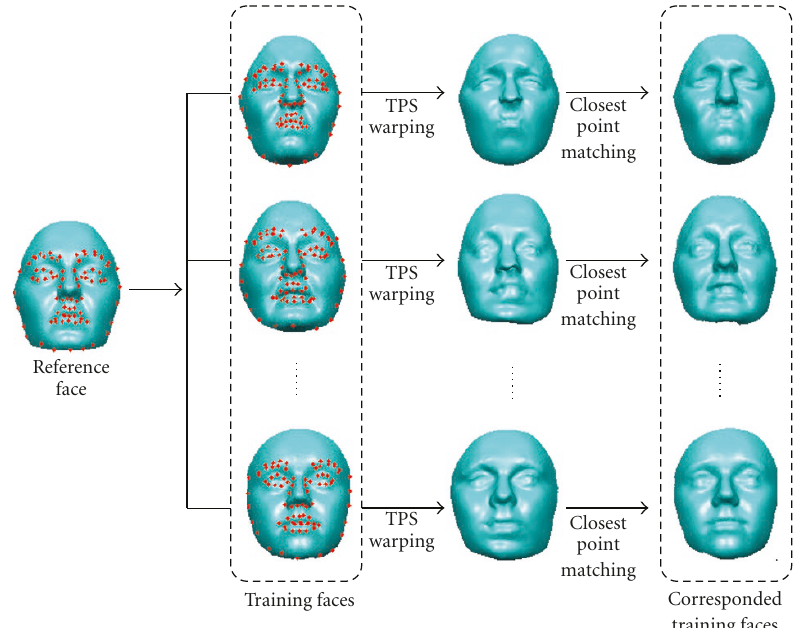
Figure 1: Example of point correspondence estimation in the training data set, with example images from the